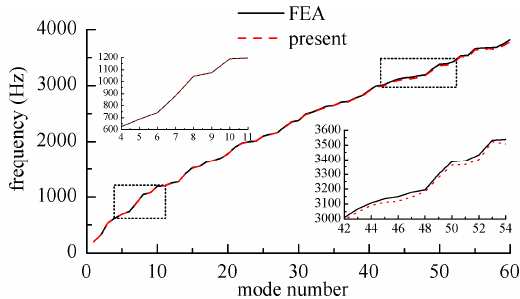
Figure 4. Nature frequency parameters for rectangular laminated plates with CFSF .